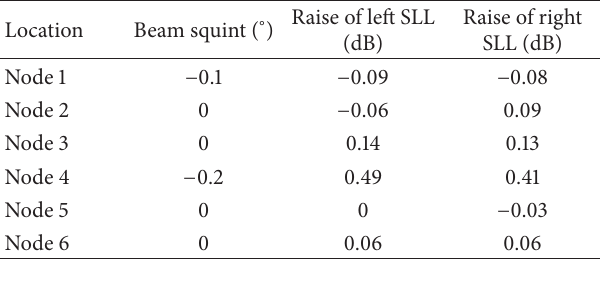
Figure 5: The photo of measurement.